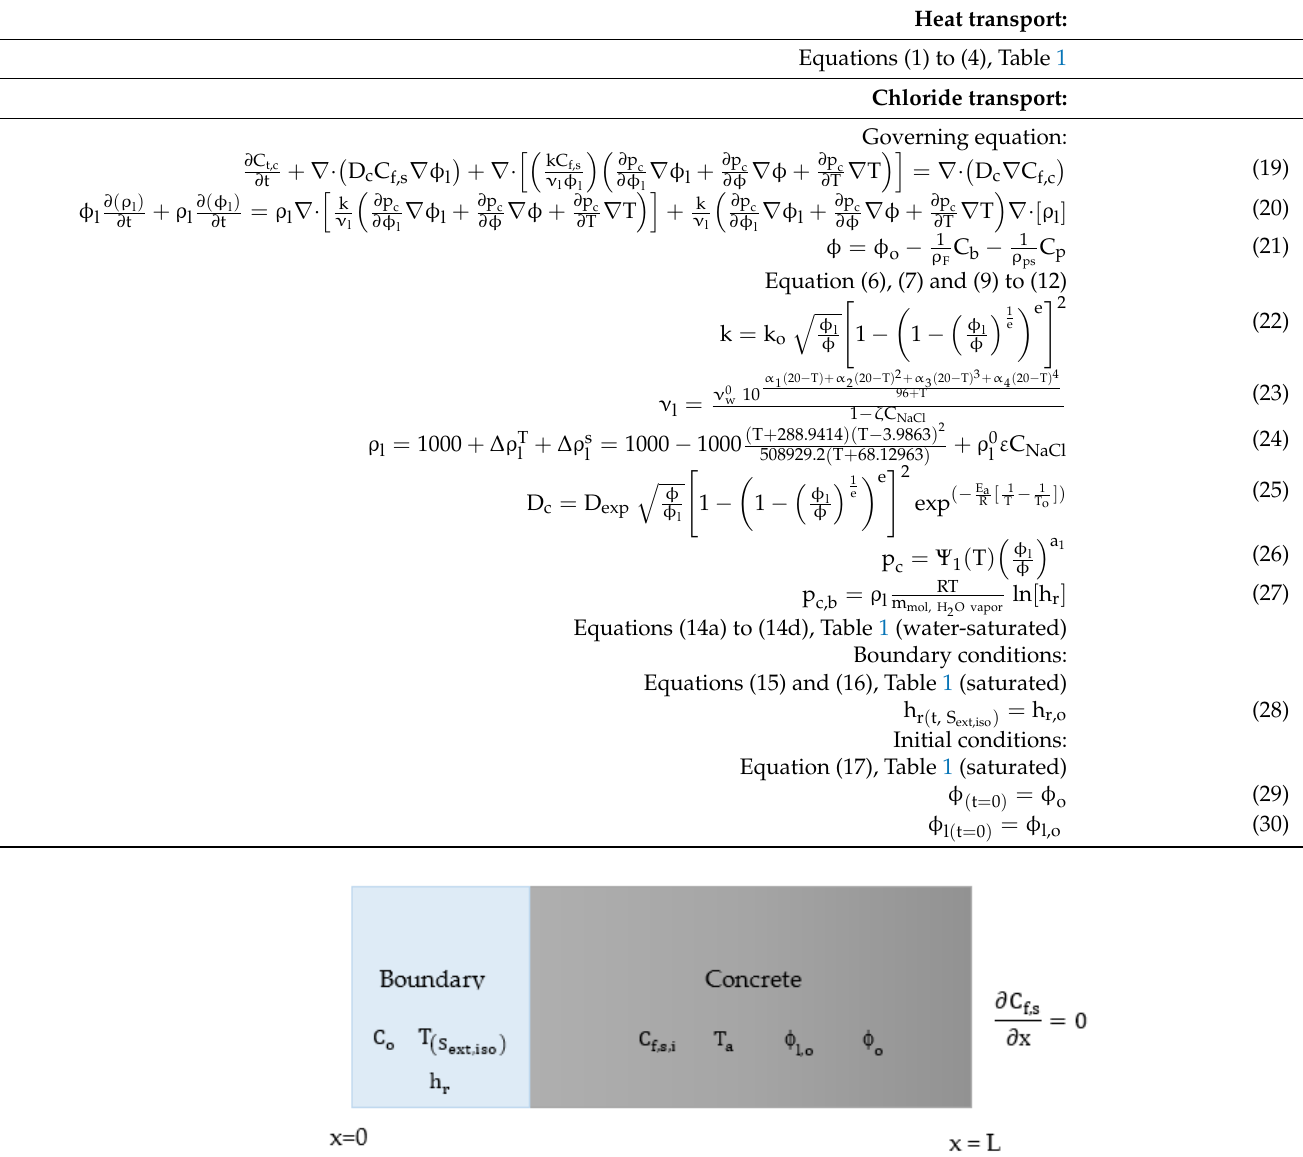
is the external tem- is the external temperature (cid:3163)(cid:3182)(cid:3178),(cid:3167)(cid:3177)(cid:3173) (cid:3439) ext,iso ) is (cid:2922),(cid:2925)